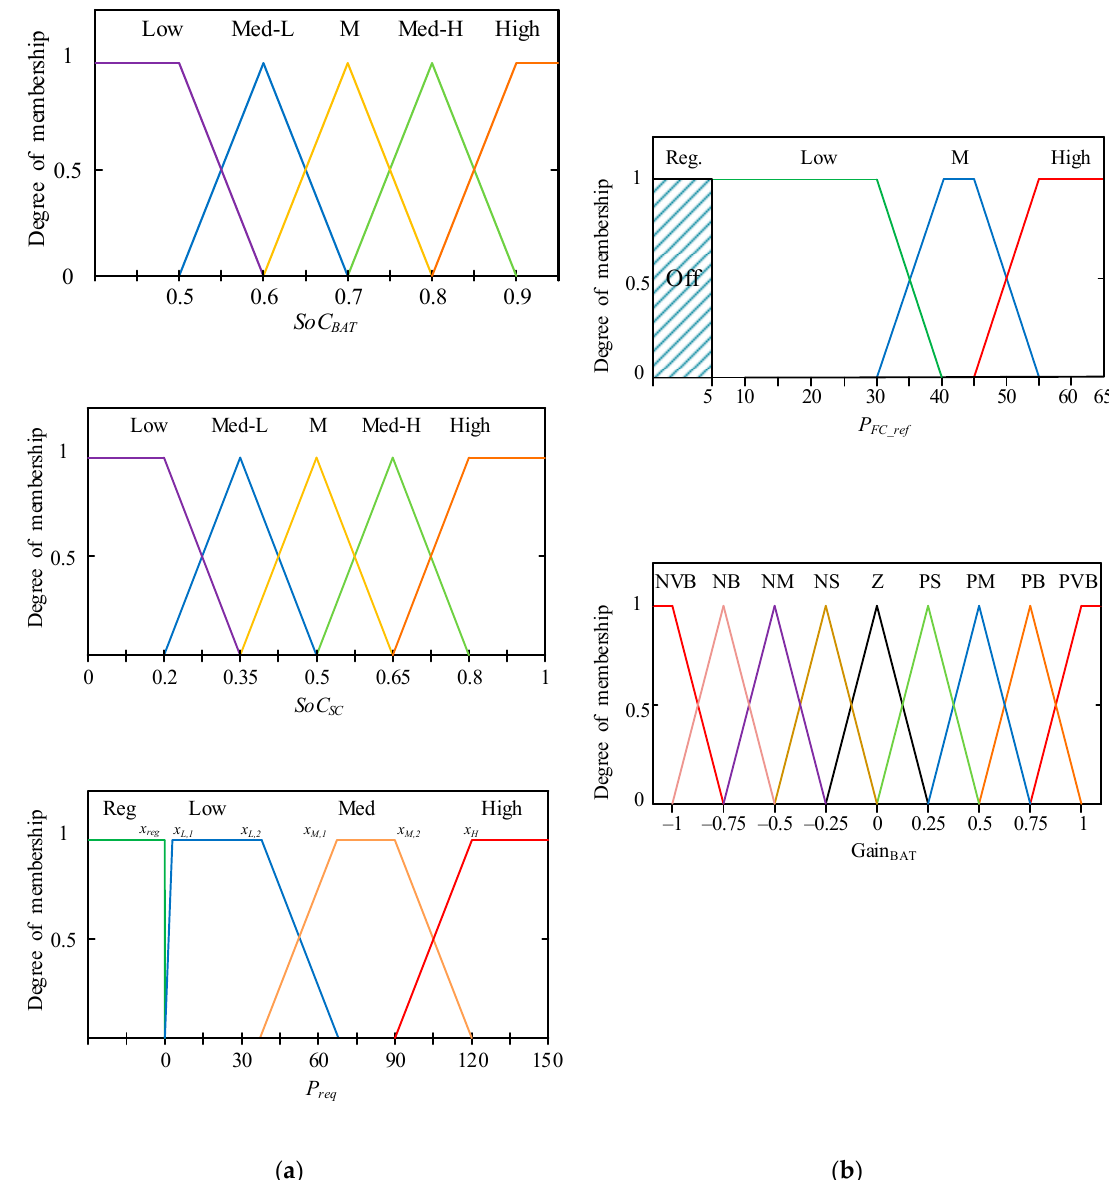
Figure 6. Structure of the FLS: ( a ) membership functions of inputs and ( b ) membership functions of outputs.